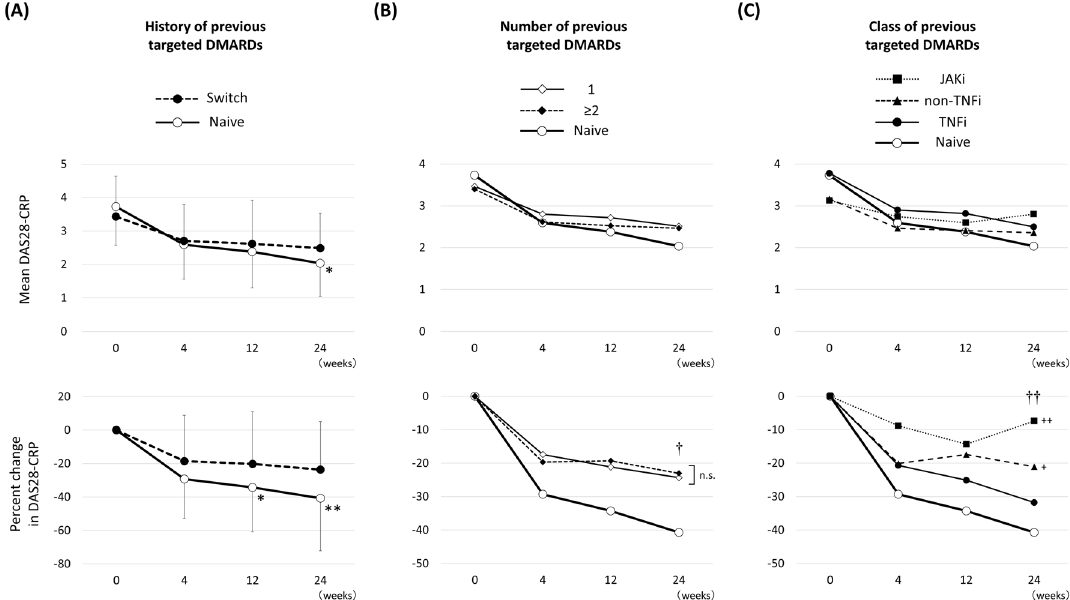
Figure 4. Mean and percent change in Disease Activity Score based on 28 joints (DAS28-CRP). ( A ) Comparisons between patients with (Switch) and without (Naïve) previous targeted DMARDs (biological or targeted synthetic DMARDs). *p < 0.05, **p < 0.01 in paired Student’s t test, compared to baseline. ( B ) Comparisons between naïve, patients with only 1, and patients with ≥ 2 previous targeted DMARDs. † p < 0.05 in one-way ANOVA. n.s. not significant in post-hoc Bonferroni test. ( C ) Comparisons between patients without (Naïve) and with previous tumor necrosis factor inhibitors (TNFi), non-TNFi (IL-6 receptor inhibitors or abatacept), and Janus kinase inhibitors (JAKi). †† p < 0.01 in one-way ANOVA. + p < 0.05, ++ p < 0.01 in post-hoc Bonferroni test, compared to